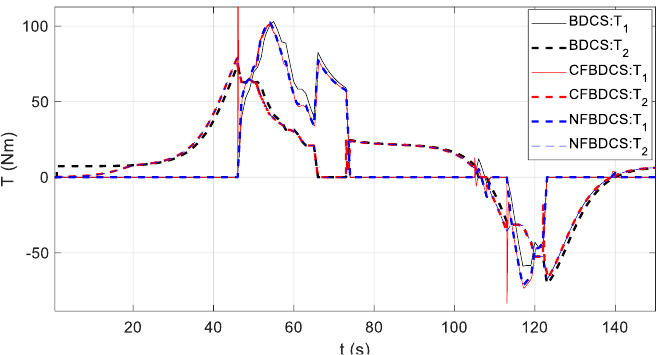
Figure 14. Driving torque of EM1 and EM2 with Δ t = 1 s.